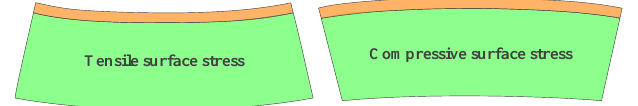
Figure 13. Schematic of the tensile surface stress (positive surface stress) inducing a concave curvature and the compressive surface stress (negative surface stress) inducing a convex